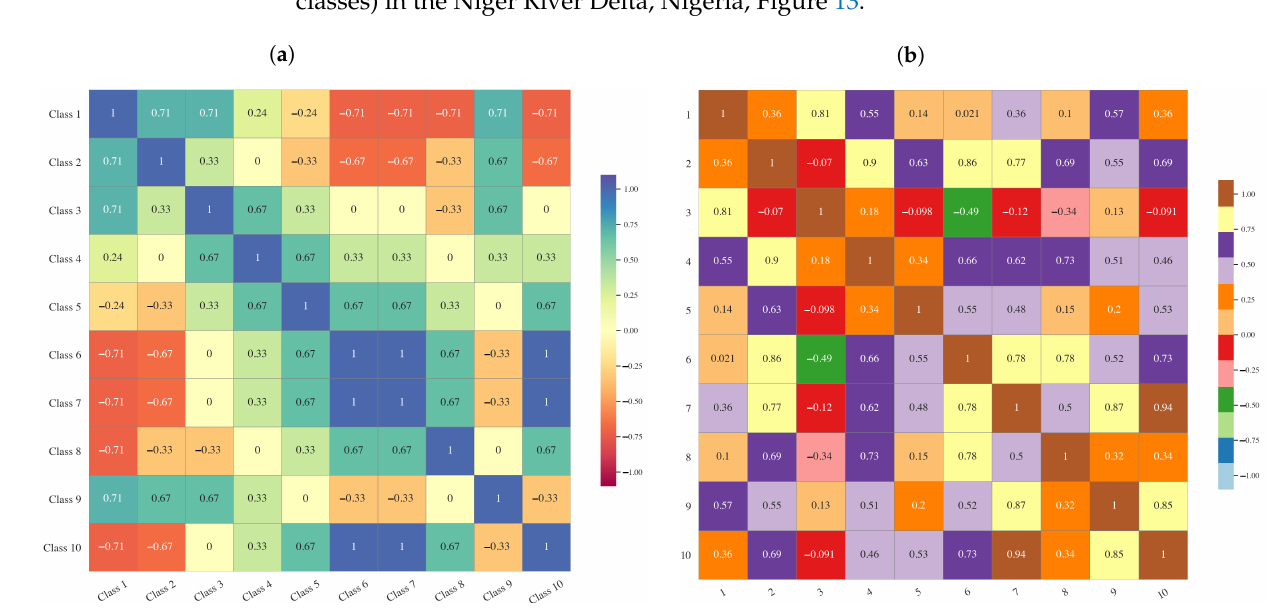
Figure 13. Correlation matrices of land cover classes (10 ID classes) in the Niger River Delta between 2013 and 2022, based on the Landsat 8-9 OLI/TIRS images: ( a ) Kendall correlation for average values; ( b ) Spearman correlation for pixels by bands 4 (Red), 3 (Green) and 2 (Blue) used for classification of land cover types. Visualization: Python. Source: